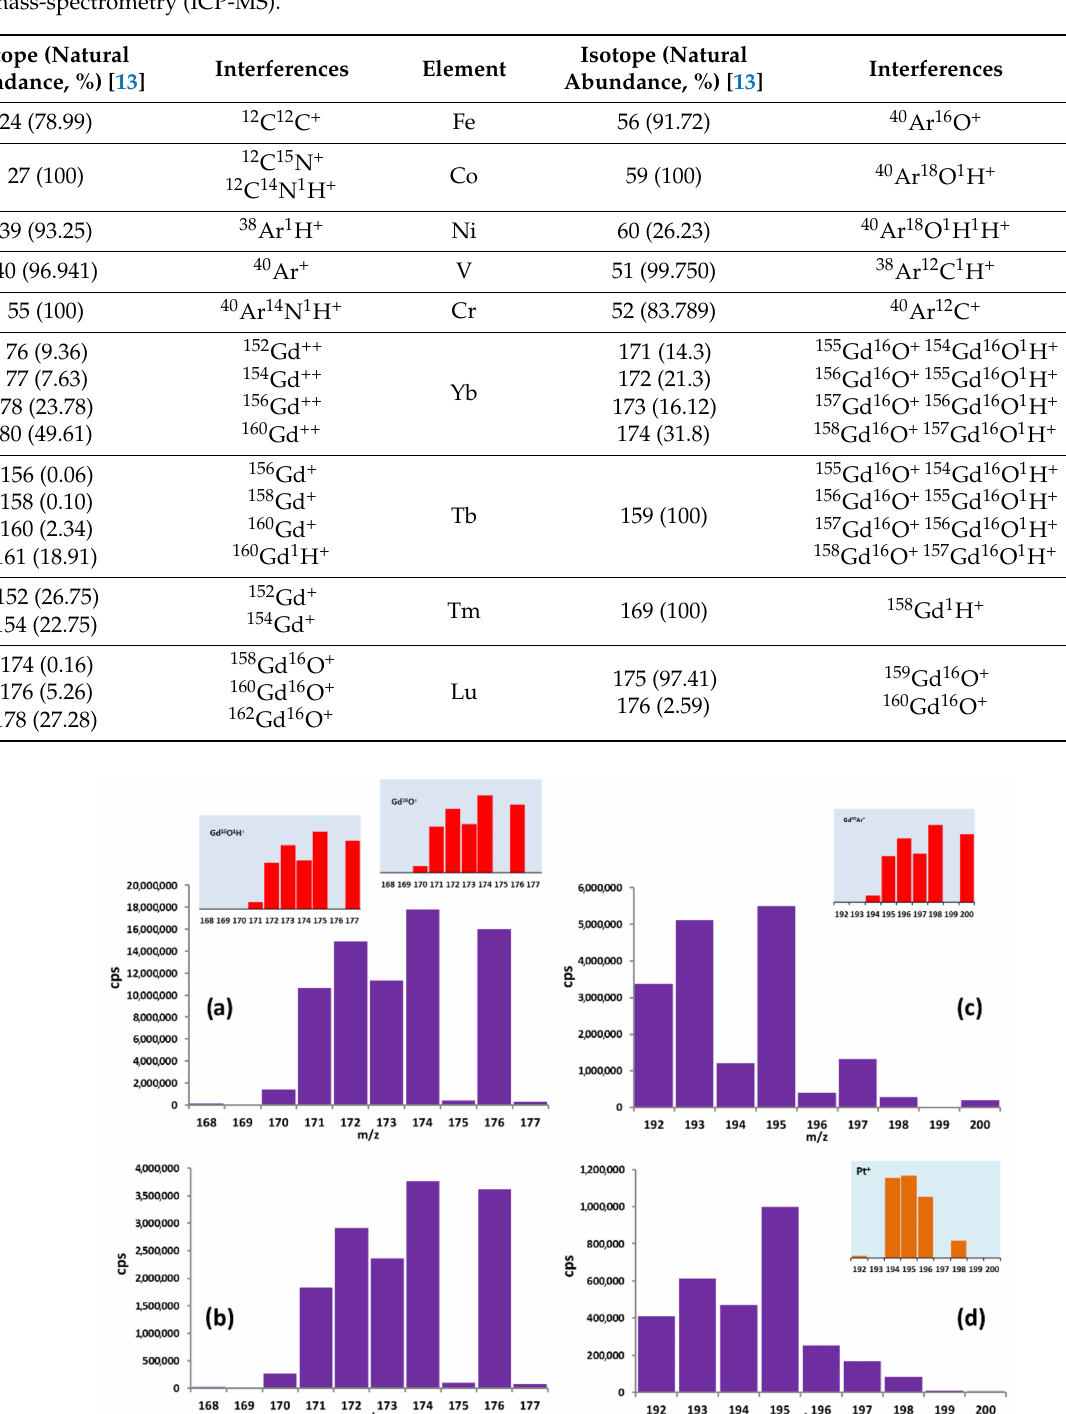
Table 3. Possible isobar overlays in the analysis of a “blank” solution obtained after dissolution and analyzed by inductively coupled plasma mass-spectrometry (ICP-MS).